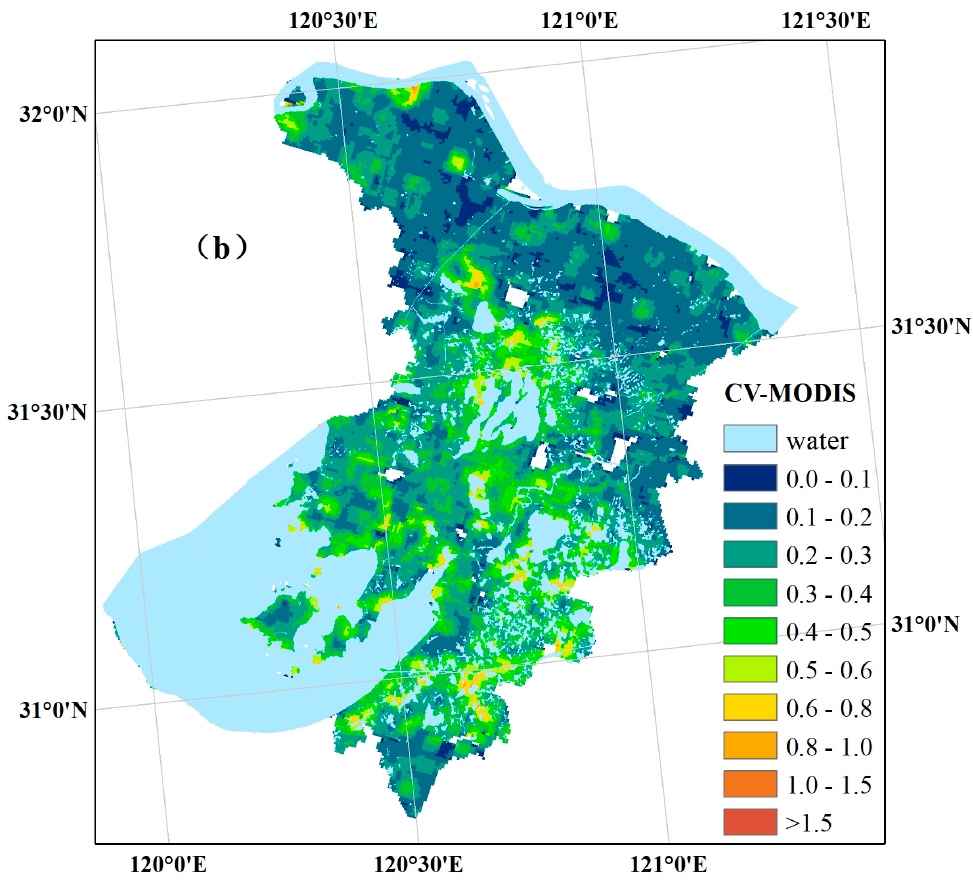
Figure 10. The GPP variation coefficient (CV) of Sentinel-2 ( a ) and MODIS ( b ).